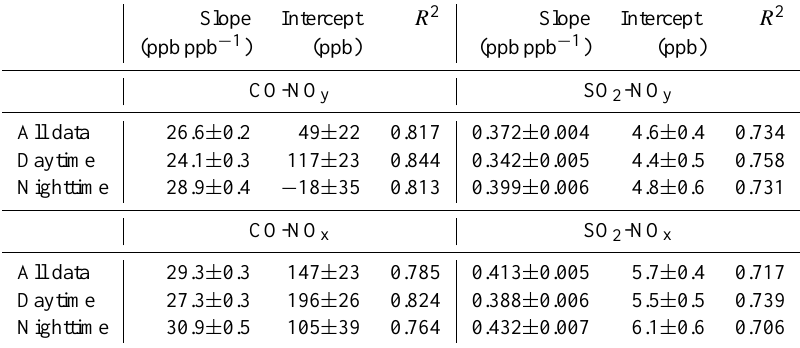
Table 2. The slopes, intercepts, with their errors, and correlation coefficients ( R 2 ) values in the regression lines of CO-NO x , SO 2 -NO x , CO-NO y , and SO 2 -NO y